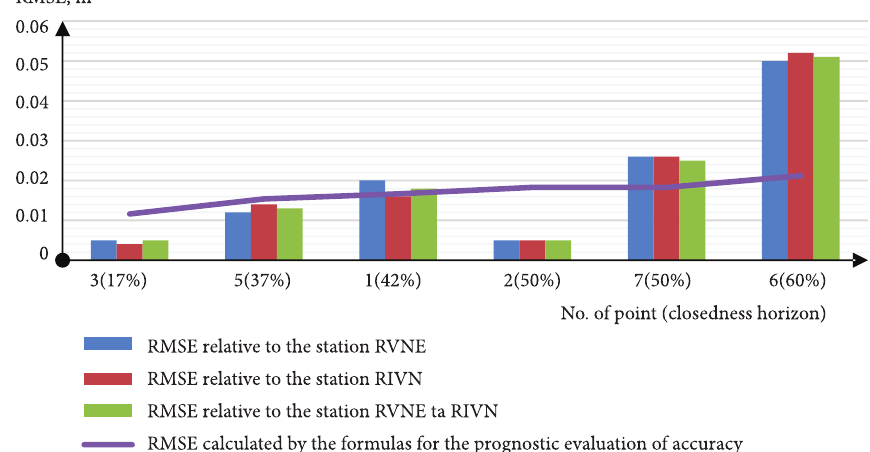
Figure 6. Comparison of RMSE of the spatial location by the session duration for 1 hour with executing the preliminary planning and prognostic points of accuracy evaluation calculated by Equation (7)